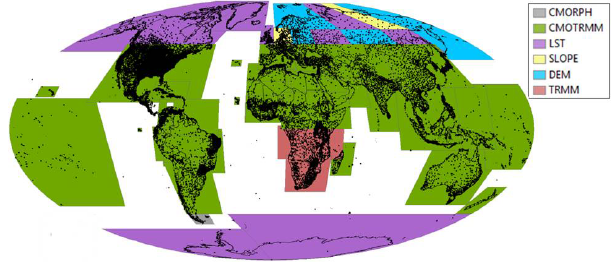
Figure 2. Best predictor, by model region, with station